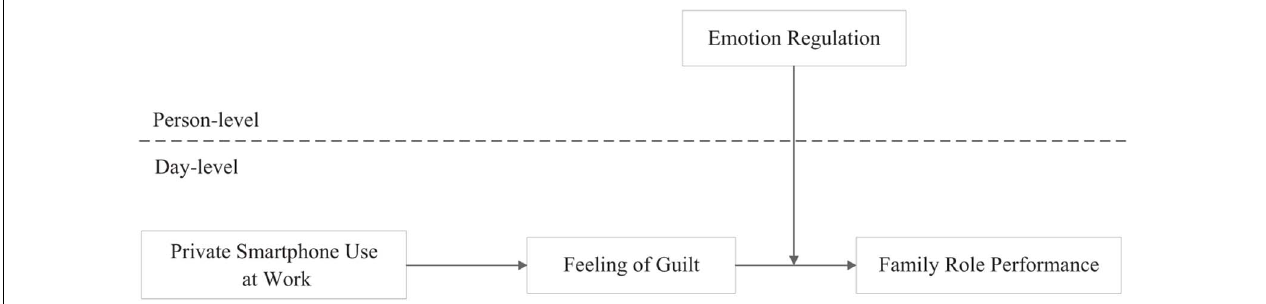
FIGURE 1 | Research conceptual